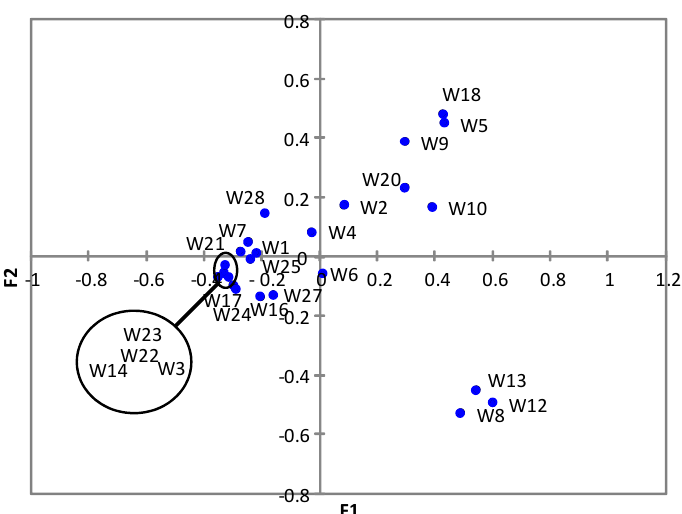
Figure 3. Principal coordinates analysis of breast milk samples taken at different weeks (W) during the sampling period.